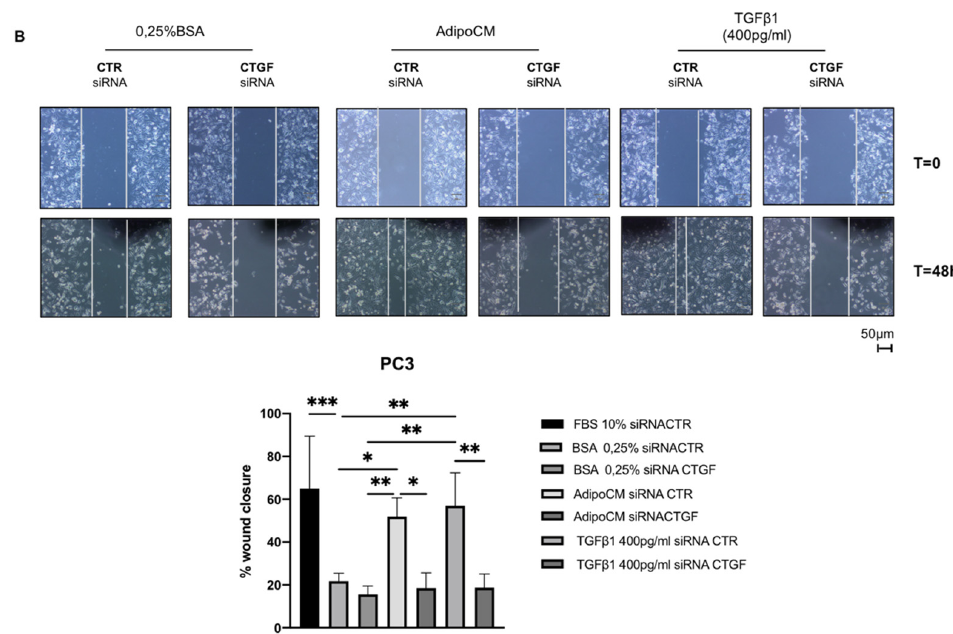
Figure 5. CTGF silencing counteracted the effect of AdipoCM on PCa cell migration. DU145 ( A ) and PC3 ( B ) cells were transfected with three different siRNAs recognizing CTGF (40 nM for DU145 and 10 nM for PC3; siRNA CTGF) or with a control siRNA (40–10 nM; CTR siRNA). After 6 h, the cells were fed with a complete medium. Then, the cells were allowed to form a confluent monolayer. Cell layers were wounded with a micropipette tip and then incubated with medium con- taining 0.25% BSA, conditioned medium obtained from adipocytes and TGF β 1 400 pg/mL. The images were acquired at 0 and 48 h using a camera connected to the microscope. Cell migration toward the wounded area was observed, photo- graphed and measured (magnification 10×). Graphs show the percentage of wound healing rate. * Indicates a p -value <0.05, ** indicates a p -value < 0.01, *** indicates a p -value < 0.001 and **** a p -value ≤